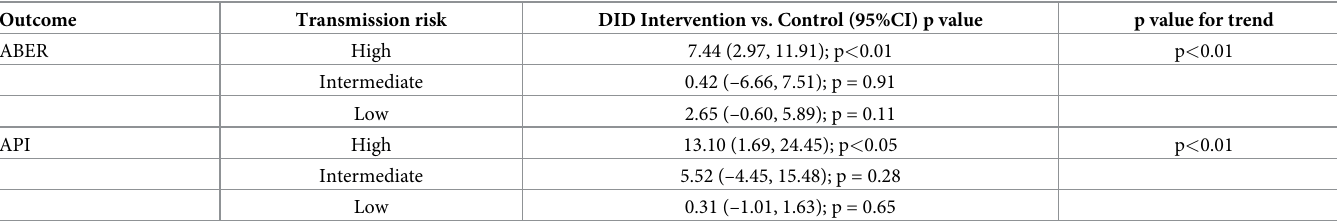
Table 5. Post − pre differences between CCMP intervention and control sub-centres stratified by transmission-risk categories for ABER and API.